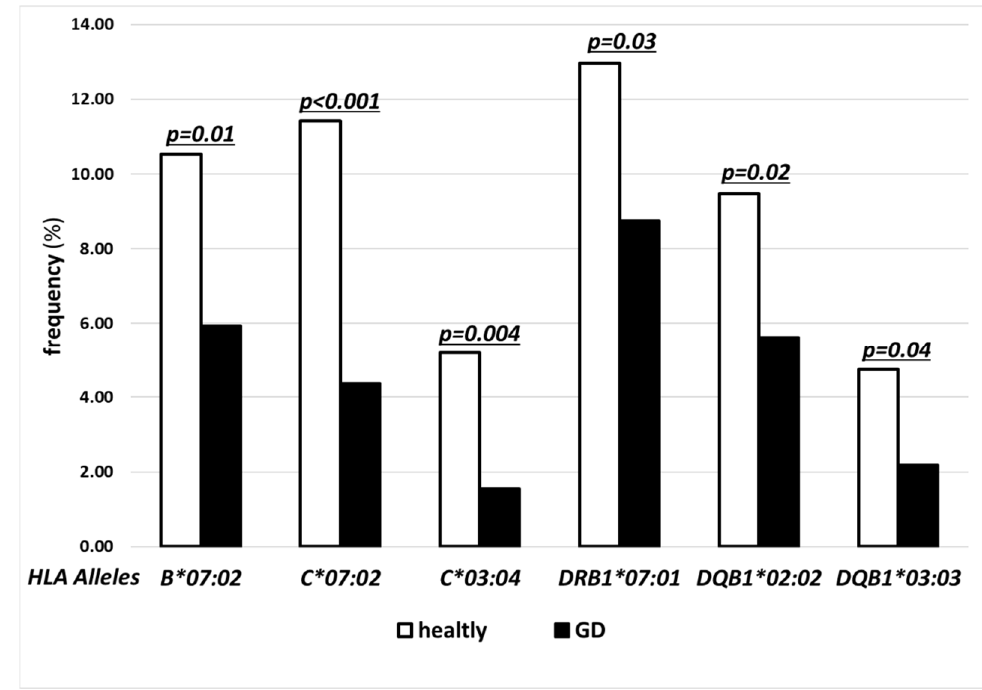
Figure 3. Frequencies (%) of human leukocyte antigen (HLA) under-represented alleles with statistical difference between controls (open bars) and Graves’ disease (GD) patients (solid bars) for both major histocompatibility complex (MHC) class I and class II alleles.